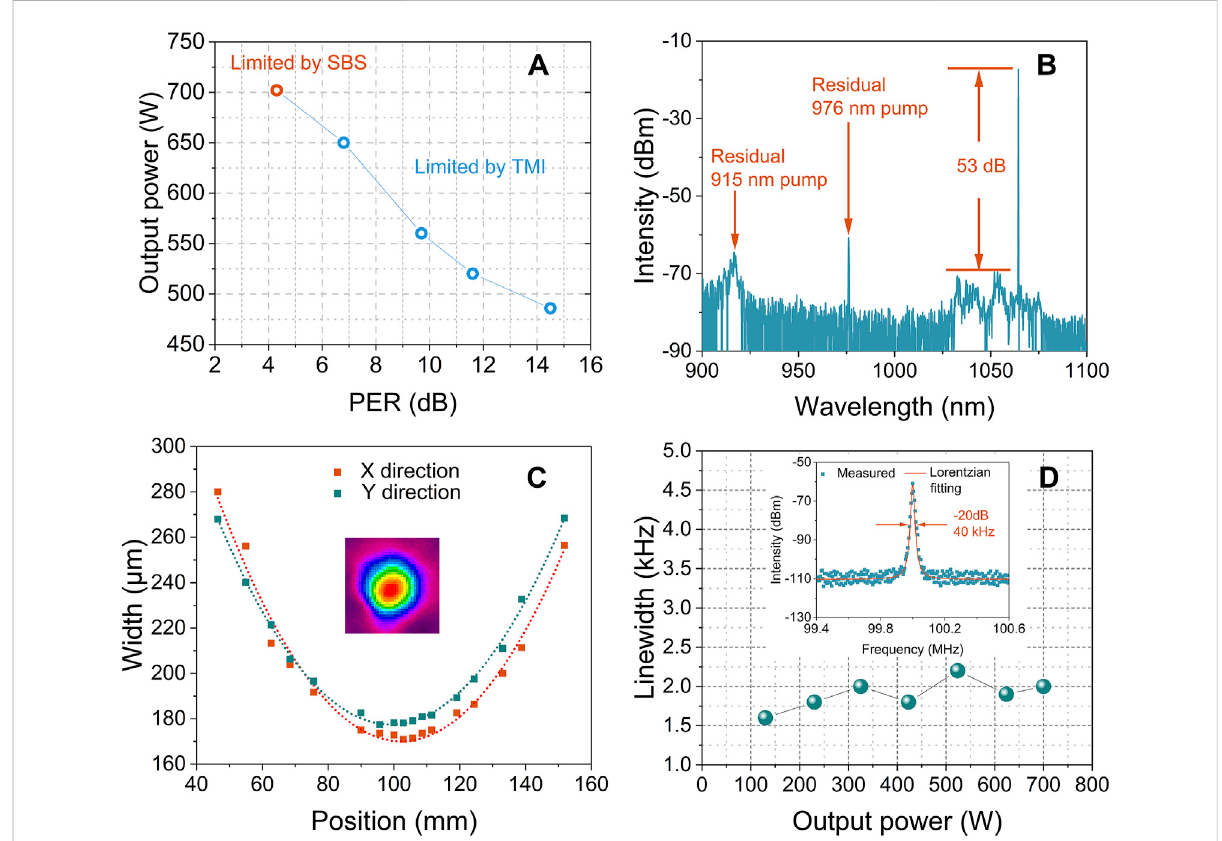
FIGURE 4 (A) The dependence of maximum available output power of the single-frequency fi ber ampli fi er on the laser seed PER, (B) optical spectrum of the single-frequency fi ber ampli fi er at the maximum output power of 703 W measured with an OSA resolution of 0.02 nm in the wavelength range from 900 to 1,100 nm, (C) measured beam quality (M 2 ) in both axes at the maximum output power of 703 W and (D) measured laser spectral linewidth of the single-frequency fi ber ampli fi er as a function of laser output power. Inset (C) Corresponding beam pro fi le and (D) measured spectral linewidth at the maximum laser output power of 703